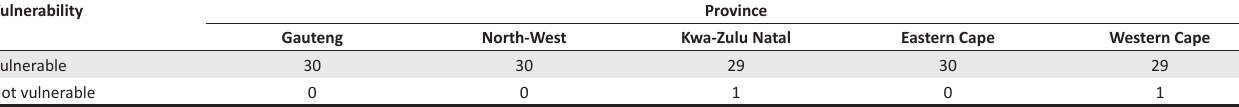
TABLE 2: Chart depicting educators’ responses about the vulnerability of South African communities.